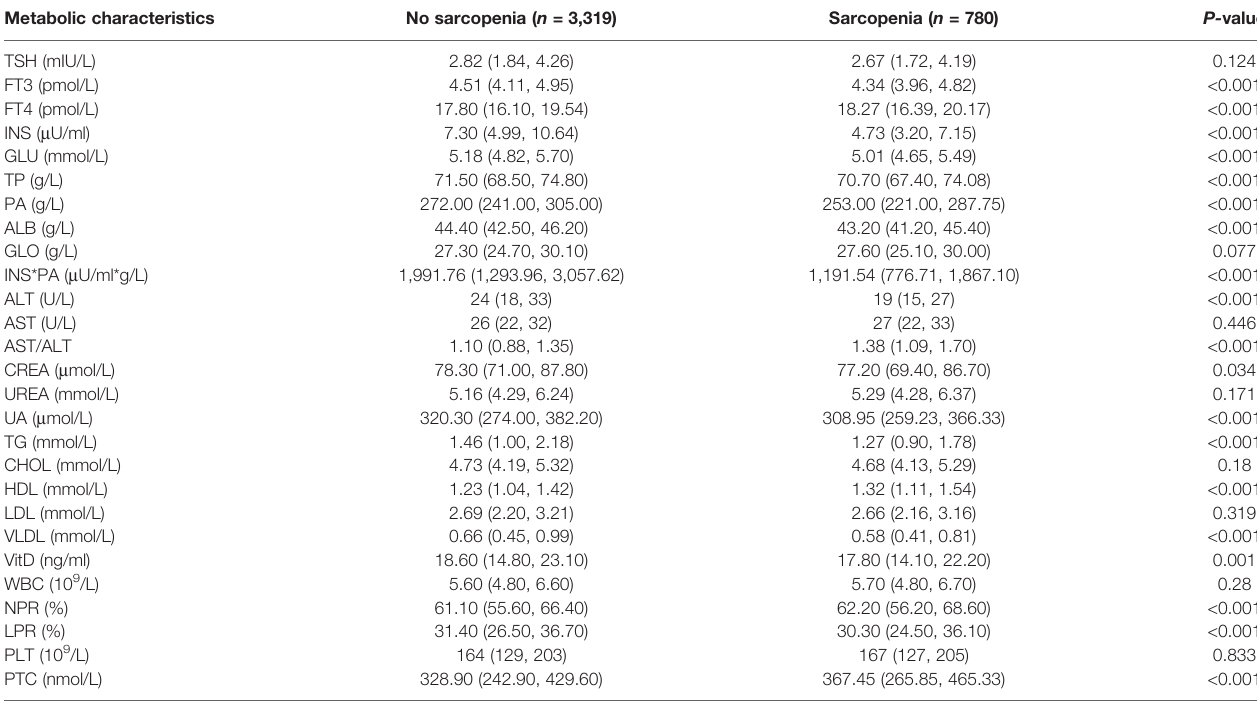
TABLE 2 | The metabolic characteristics of elderly participants strati fi ed by